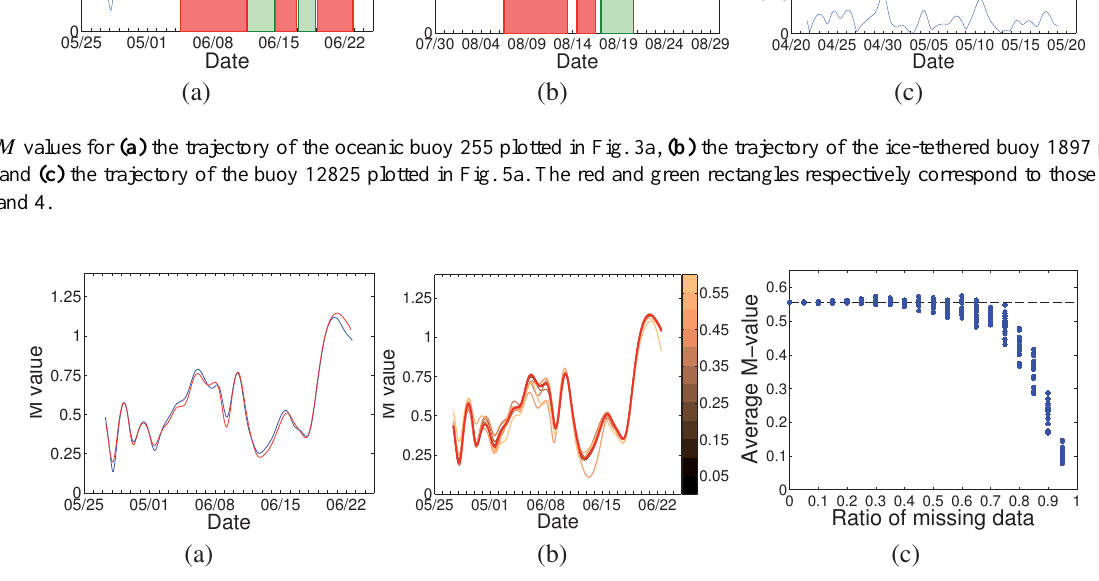
Fig. 7. (a) M values for the trajectory of the oceanic buoy 255 plotted in Fig. 3 (raw data: blue line, same as Fig. 6a) and the trajectory obtained after a cubic interpolation and a 3h resampling of the raw positions (red line). (b) M D time series computed from the degraded datasets of missing data ratio varying between 0 and 60% (the red line is the same as in a ). (c) M D values averaged over the whole trajectory (1month) as a function of the missing data ratio. 20 realisations have been done at each given value of missing data ratio. The grey dashed line shows the average raw M value, equal to